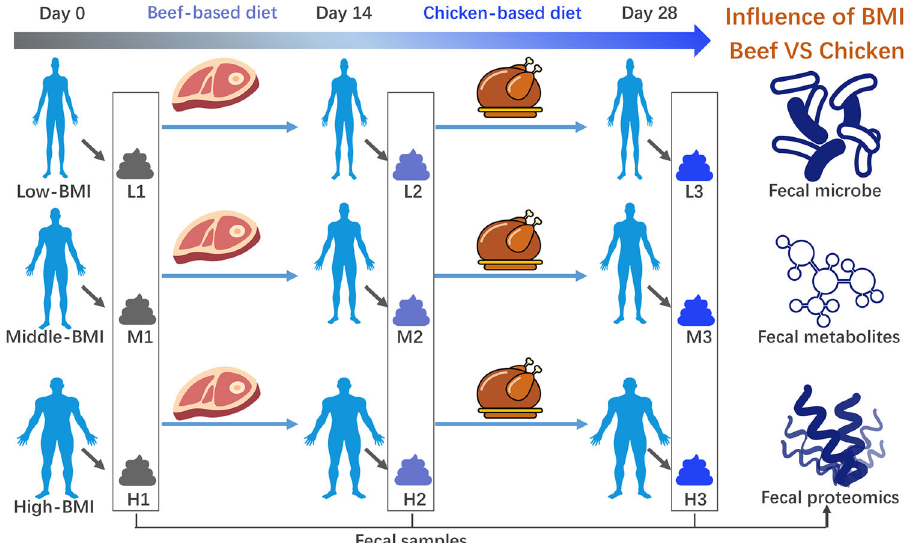
Fig. 1 Schematic diagram of parallel assay to determine in fl uence of meat-based diets on fecal microbes, metabolites and fecal proteomics of male volunteers with different BMI ranges. Volunteers in each BMI group were supplied with a beef-based diet for 2 weeks and then replaced by a chicken-based diet for another 2 weeks. The measured variables were compared among three BMI